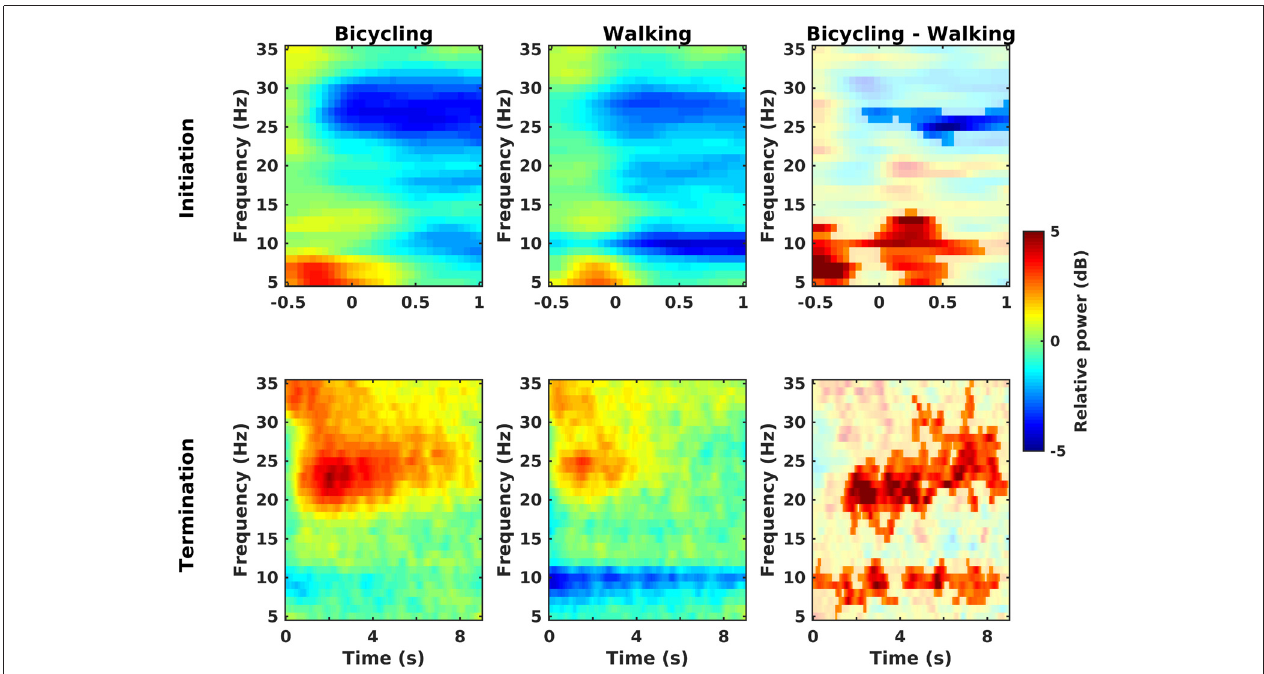
FIGURE 3 | Initiation and termination of movement . Grand average time-frequency representations of power changes locked to a change of the movement state relative to the baseline rest period (in dB) for bicycling, walking, and the difference between both (non-significant differences masked). Upper row: Movement initiation is at t = 0. In both conditions power decreases (blue) occur in the alpha , low and high beta band, but with a stronger high beta power decrease in bicycling and a stronger alpha power decrease in walking. Lower row: Movement termination is at t = 0. In both conditions power increase (red) occurs in the beta band. Contrasting bicycling and walking revealed a difference in the temporal evolution both of the beta rebound and of the alpha power